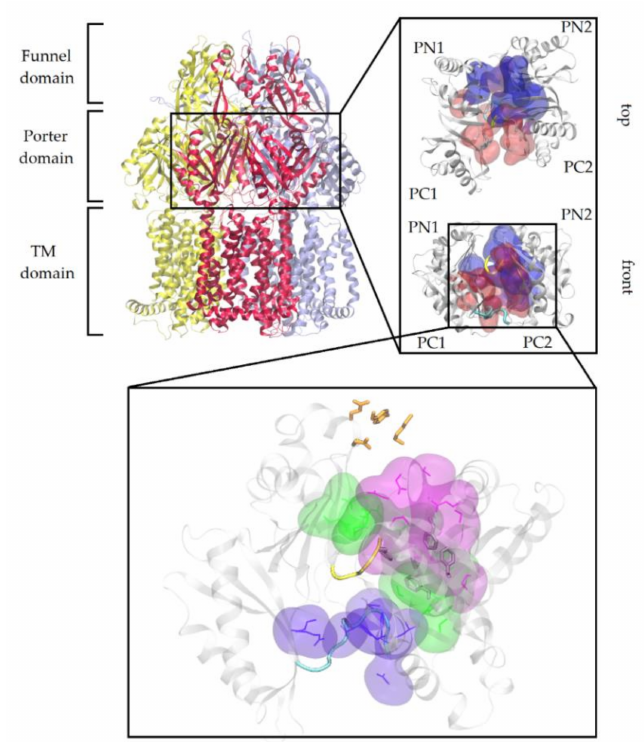
Figure 1. View of the AcrB trimer. The access, binding, and extrusion protomers of AcrB are represented as yellow, red, and ice blue ribbons, respectively. The inset shows a front and top magnification of the porter domain of the T monomer of AcrB highlighting PN1, PN2, PC1, and PC2 subdomains and the access and deep binding pockets represented as red and blue surfaces, respectively. The second inset shows the main regions of interest discussed in this study, as reported in Table S1. The switch-loop and the bottom loop are displayed as yellow and cyan tubes, respectively. HP-trap and exit gate residues are shown as gray and orange sticks, respectively. Interface, groove, and cave residues are represented as violet, green, and purple surfaces and lines respectively. Protein residues lining each region are reported in Table